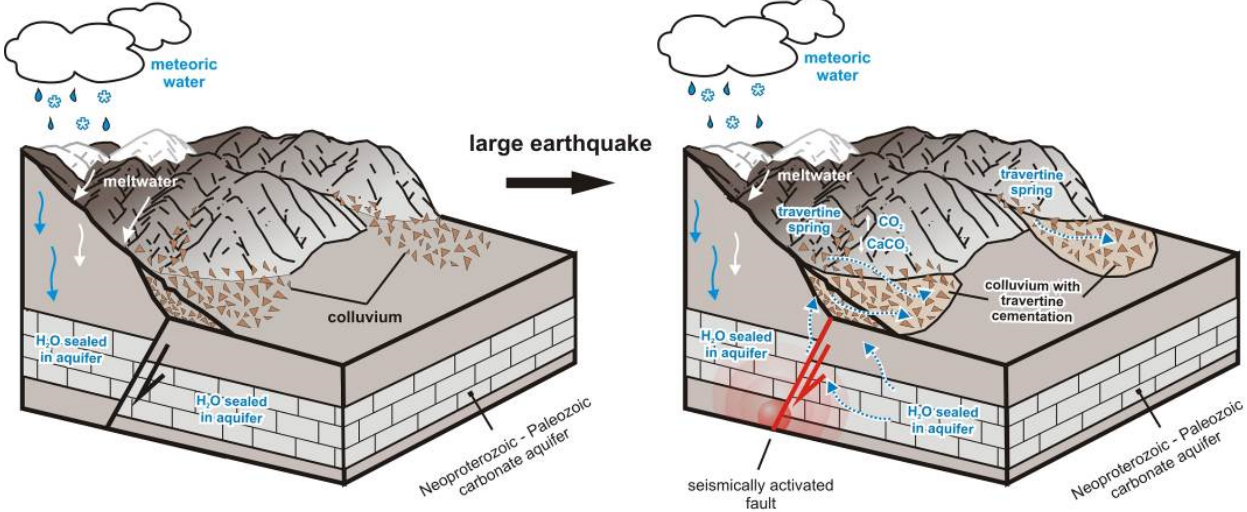
Figure 18. Generalized model of the formation of the south-eastern Gorny Altai travertines.